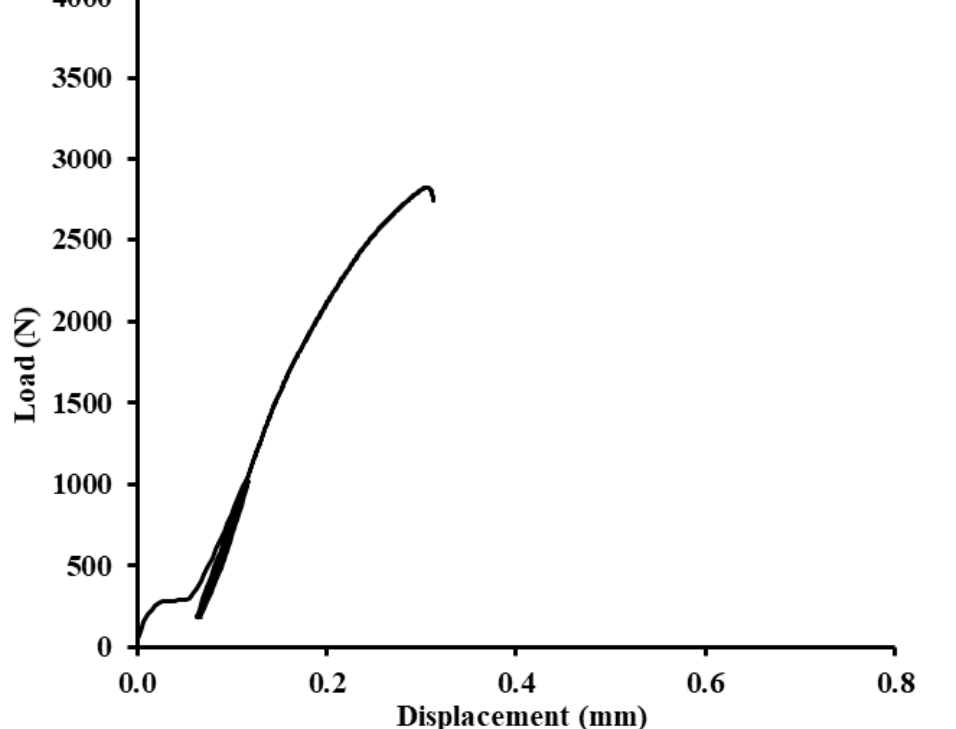
Polymers 2020 , 12 , x FOR PEER REVIEW 11 of 17 Figure 11. Quasi-static graph of adhesive bond ABFE0 with loading 5–70% (165–2307 N)—256 cycles.